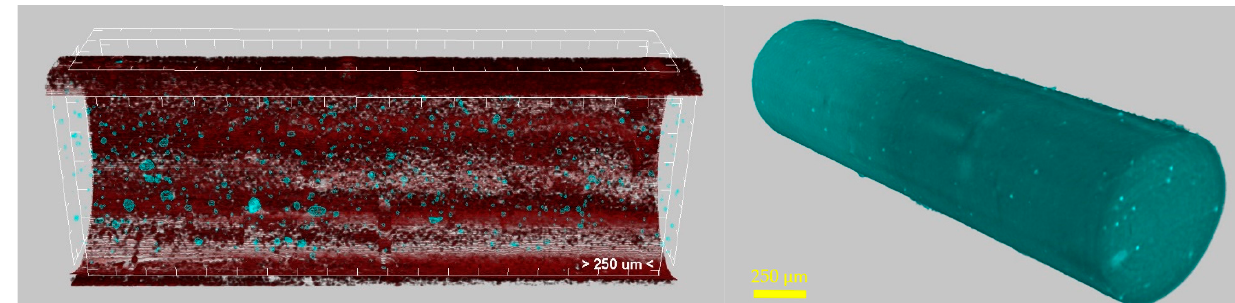
Figure 9. Micro-CT analysis images of PA12_15% GNPs + 1%CNTs.